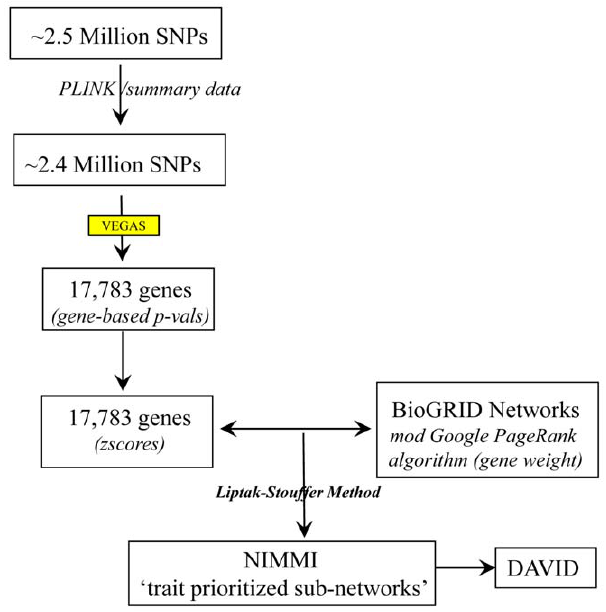
Figure 1. NIMMI flowchart. An overview of the dataflow in NIMMI is shown in Figure 1. The data shown here is drawn from the InCHIANTI height GWAS dataset. Approximately 2.5 million SNPs were analyzed using PLINK setting the parameters as specified under GWAS data module (see Design and Implementation). This resulted in , 2.4 million SNPs with association p-values, which were then assigned to 17,783 genes. Gene assignment and gene-based p-values were calculated using VEGAS. These gene-based p-values were converted to z-scores and combined with gene weights (calculated by the modified Google PageRank algorithm) in the network using the Liptak-Stouffer method to identify the ‘trait prioritized sub-networks’ that were evaluated in